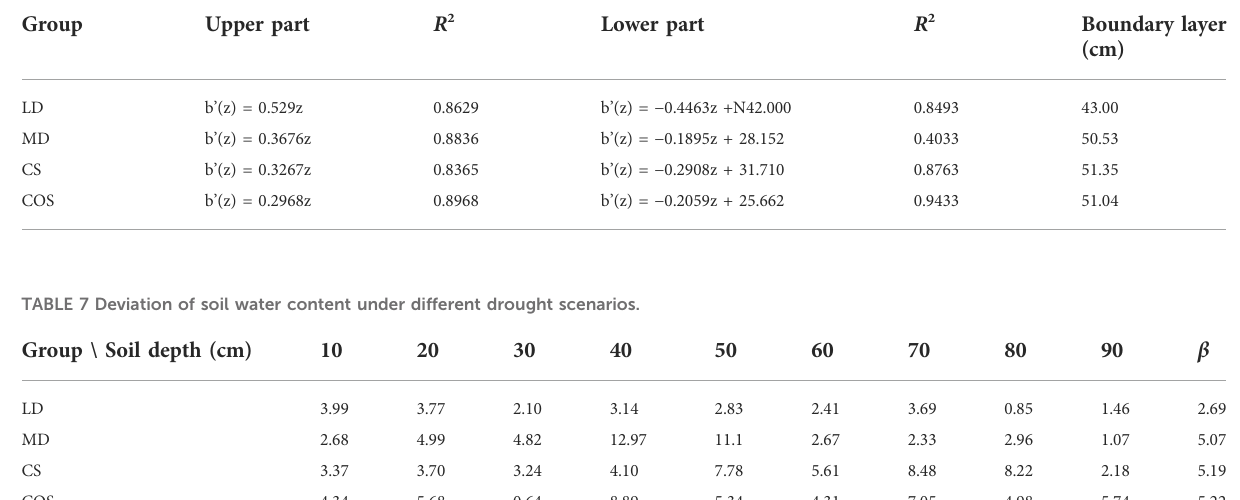
TABLE 6 Distribution function of root length density of summer maize under different drought conditions.